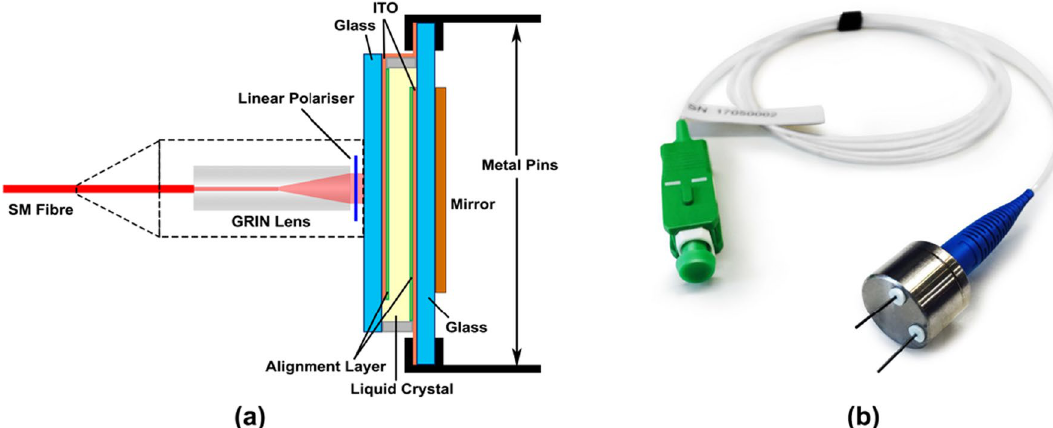
Fig. 2 Diagram showing the architecture of a typical liquid crystal (LC) transducer cell and packaged transducer with two electrical inputs (sig- nal) and a single mode fibre